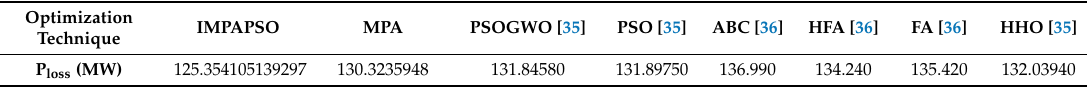
Table 9. IEEE 118-bus system’s first case objective performance.